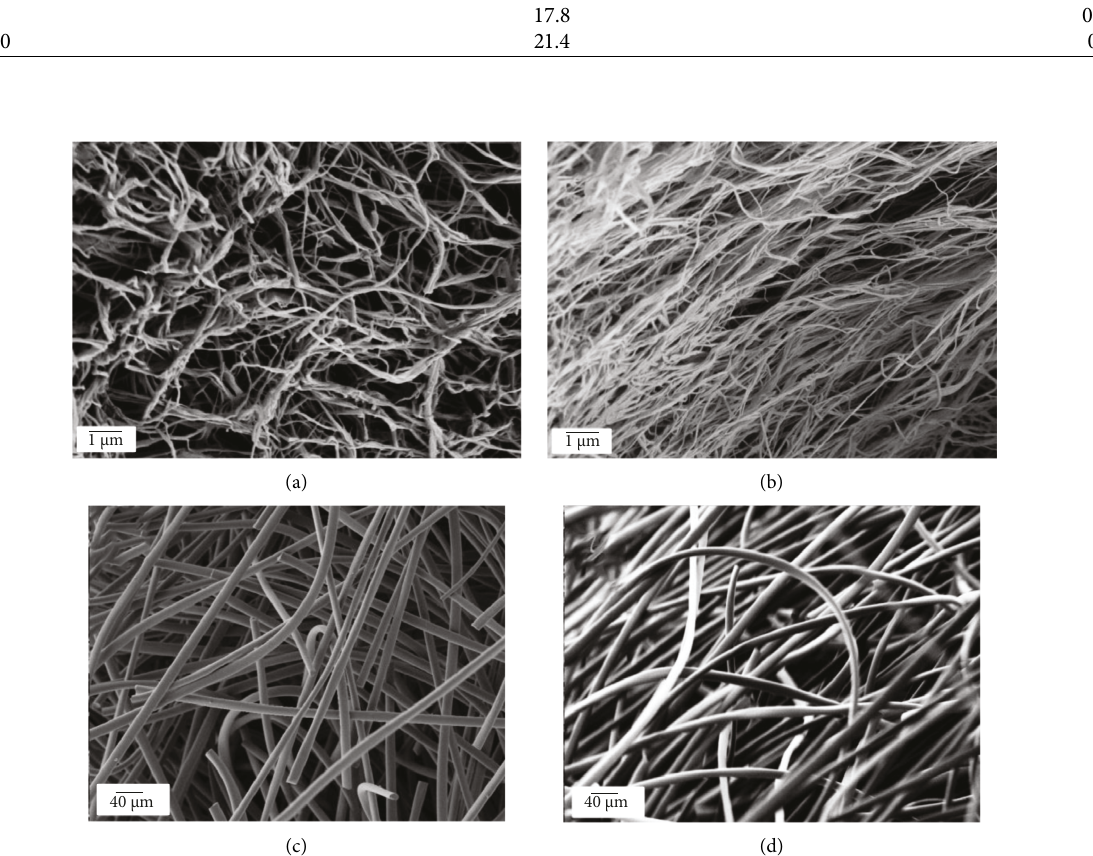
Figure 4: Comparison between the morphology of nanocellulose samples in (a) uncoated and (b) after TiO uncoated fiber, and (d) Kynol after TiO 2